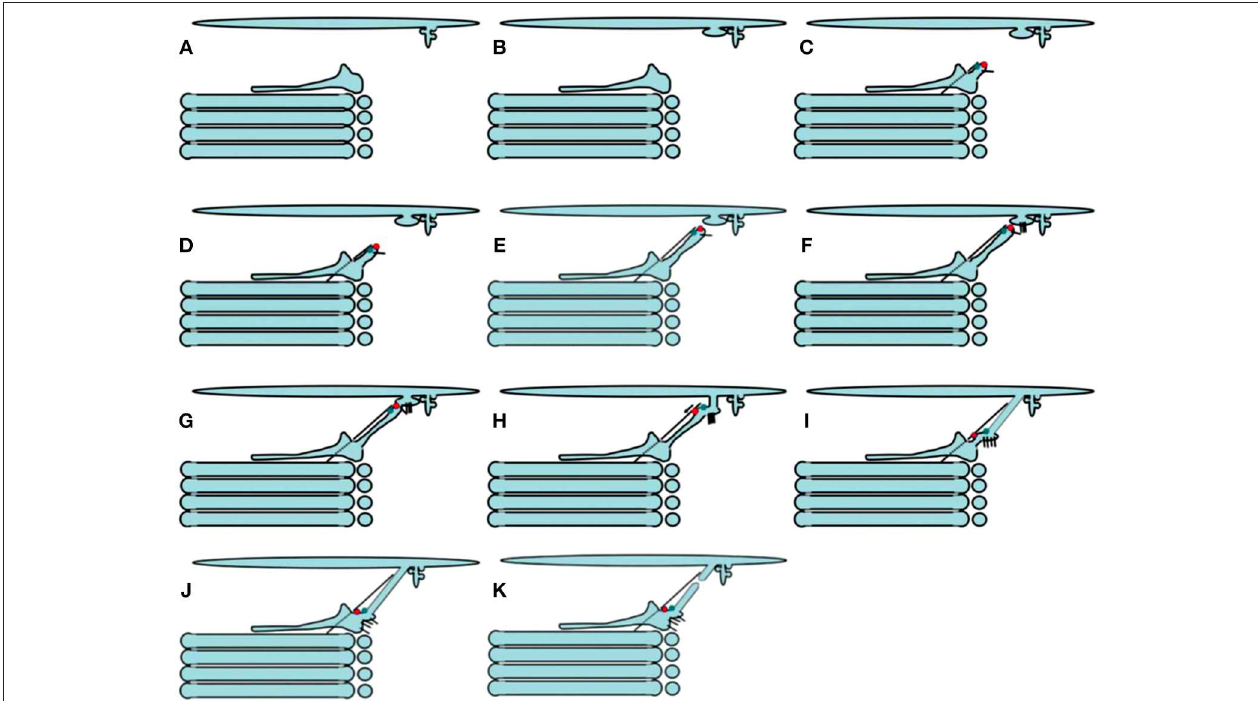
FIGURE 4 | Scheme of ER-to-Golgi transport according to the KARM. Protrusions containing small cargoes (A) and megacargoes (B) are formed within the ERES area. (C–F) A tubule is formed from the cis- most Golgi cisterna. It moves toward the ERES area along a microtubule (dashed line), with the help of kinesin (green dot). (G,H) This tubule fuses with ERES with the help of SNAREs (short black lines), and delivers dynein (red dots) to the ER-to-Golgi carrier. (I,J) The bolus moves toward the Golgi complex using dynein and microtubules. (K) Now, the ER-to-Golgi carrier is within the cis- most cisterna. Finally, the tubular connection undergoes rupture (K)